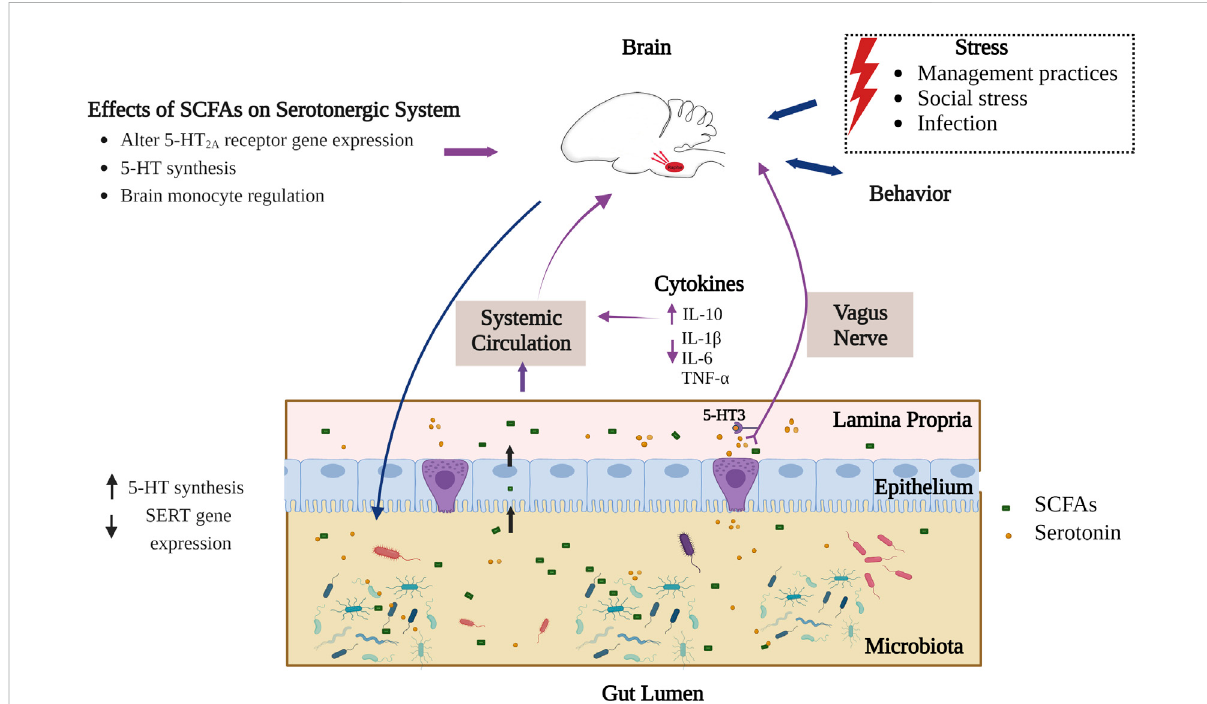
FIGURE 2 Interaction of SCFAs and serotonergic system in the gut-brain axis. Part of the SCFAs produced in gut lumen interact with the central serotonergic systemdirectly(crossingintestinal andblood-brain barrier)byepigeneticmodulationandviaactivating extrinsic primaryafferentvagus nerve (interaction of SCFAs through FFAR3). Serotonin is synthesized by both enterochromaf fi n cells of the gut epithelium and by gut microbiota. SCFAs also stimulate intestinal serotonin synthesis whereas extracellular serotonin binds to 5-HT3 receptors on afferent vagus nerve and communicatessignals to theCNS. Ontheotherhand, differentexternal stressors affectgut microbial compositioninbirdsthroughtheHPAaxis and in fl uences production of microbial metabolites like SCFAs. The blue arrows indicate established connection in birds while the violet arrows indicate connections known to occur for some animals but not yet identi fi ed in birds (Liu et al., 2012; Sealy and Chalkley, 1978; Yamawaki et al., 2012; Huuskonen etal., 2004;Cook etal.,2021;Gill etal.,2013;Essienet al.,2013;Cale fi etal.,2016;Nogueraetal., 2018;Gershon and Tack,2007;Meyer et al., 2012). Figure created with